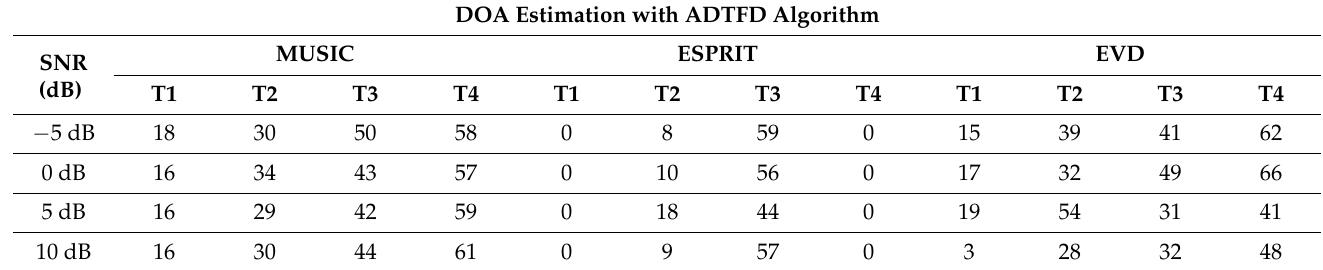
Table 2. DOA estimation results using the ADTFD algorithm.